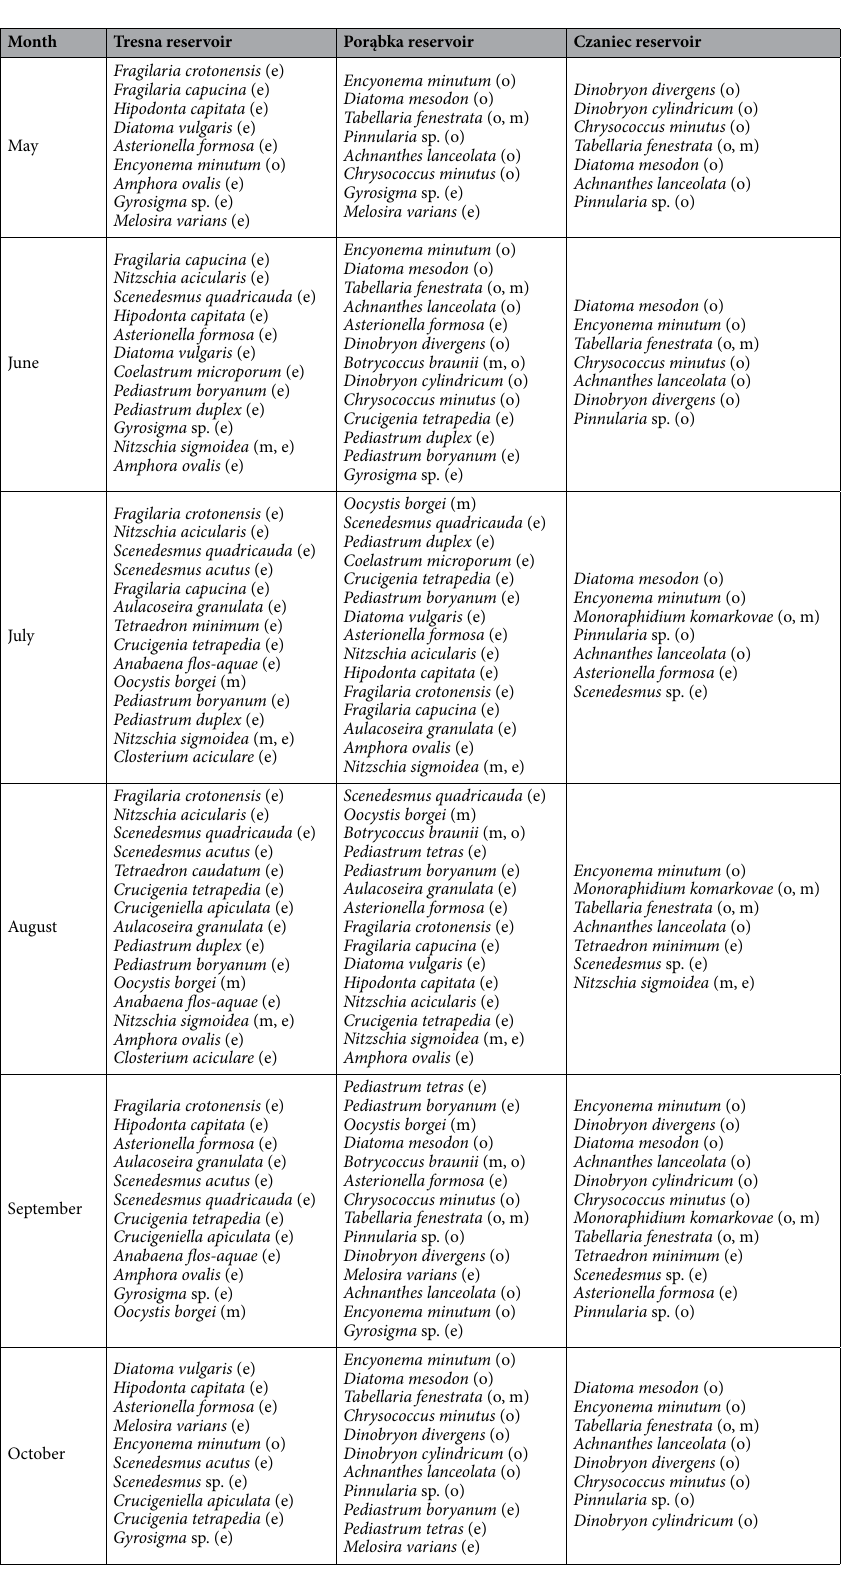
Table 2. The indicator algae in the reservoirs of the Soła cascade in 2019 year, characteristic for the conditions of eutrophy (e), mesotrophy (m), oligotrophy (o)—sorted by number of algae (from largest to